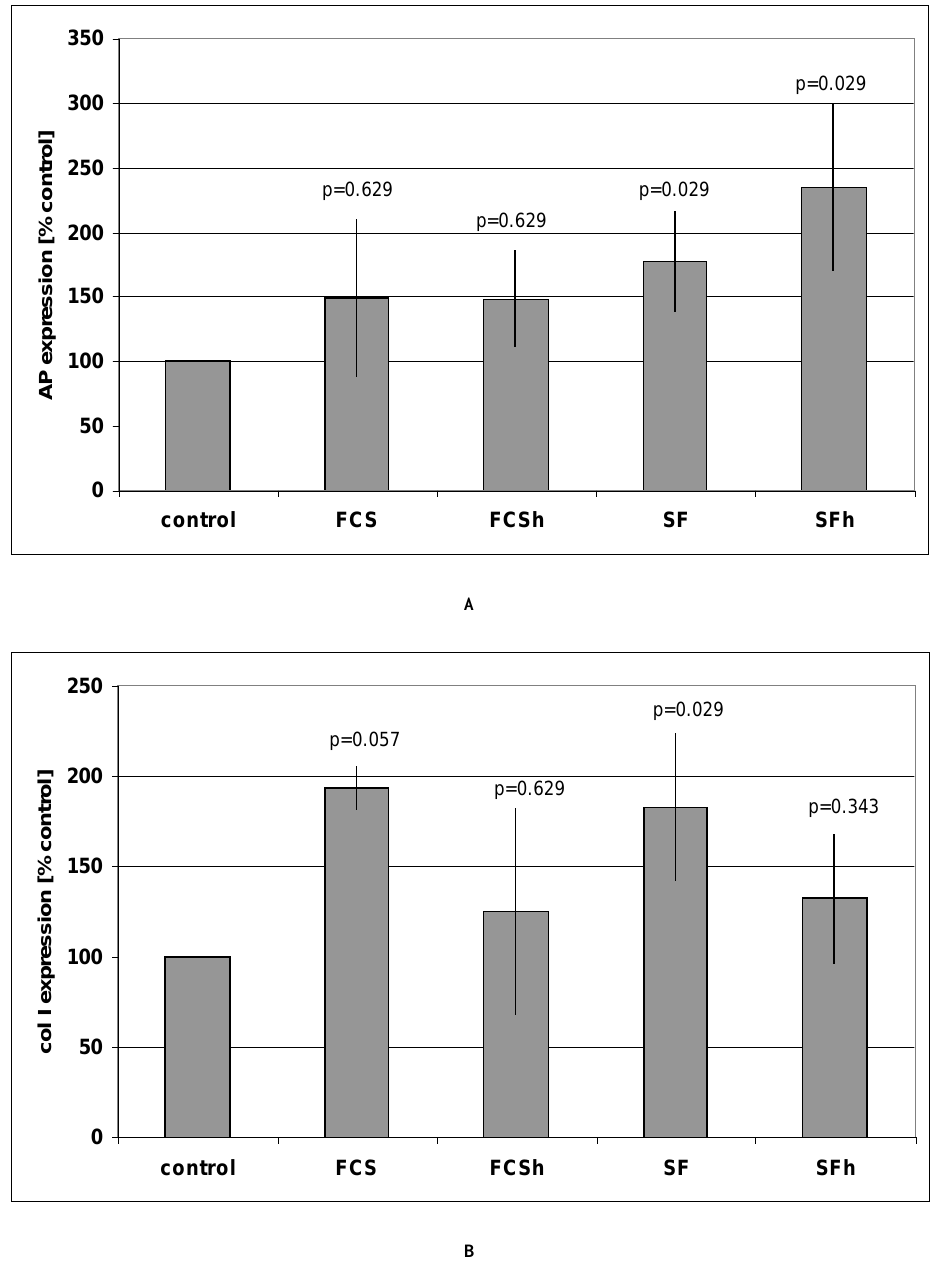
FIGURE 3. Influence of SF on expression of bone-related proteins. Human osteoblasts were cultured at a density of 1 × 10 5 cells/well in 24 well plates in the presence of SF, SFh, FCS, and FCSh over a time period of 24 h. Gene expression of alkaline phosphathase (A), collagen I (B), and osteocalcin (C) was measured relative to 18s expression. Values are shown as mean ± SEM of three independent